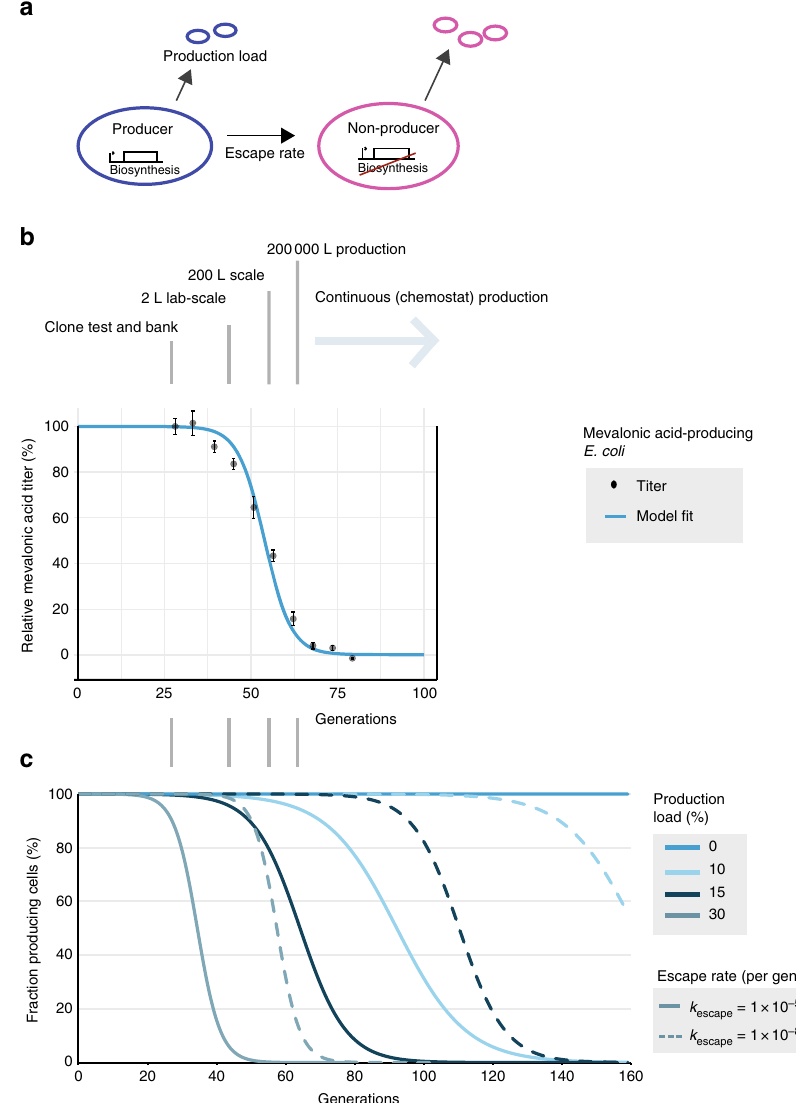
Fig. 2 Mathematical modeling is consistent with the observed mevalonic acid production titer. a Producer cells mutate from the production state at a speci fi c escape rate, thereby alleviating the production load ( fi tness cost of production; Supplementary Note 1). b The best fi t of the mathematical model (Supplementary Table 5) to the observed mevalonic acid titer throughout laboratory-simulated mevalonic acid fermentations (relative to earliest time point, Supplementary Table 3). Error bars indicate the s.e.m. ( n = 5). For reference, possible reactor sizes corresponding to particular generation numbers are shown (Supplementary Table 1). c Modeled fractions of producer cells remaining in the population, in which producer cells irreversibly mutate to non- producers at various escape rates. The magnitude of the production load drives the rate by which spontaneously formed non-producers will enrich